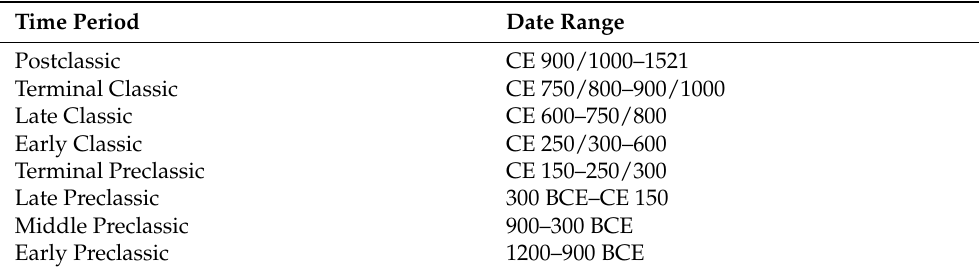
Table 1. Chronology for the Belize River Valley (based on radiocarbon dating and ceramic analysis see